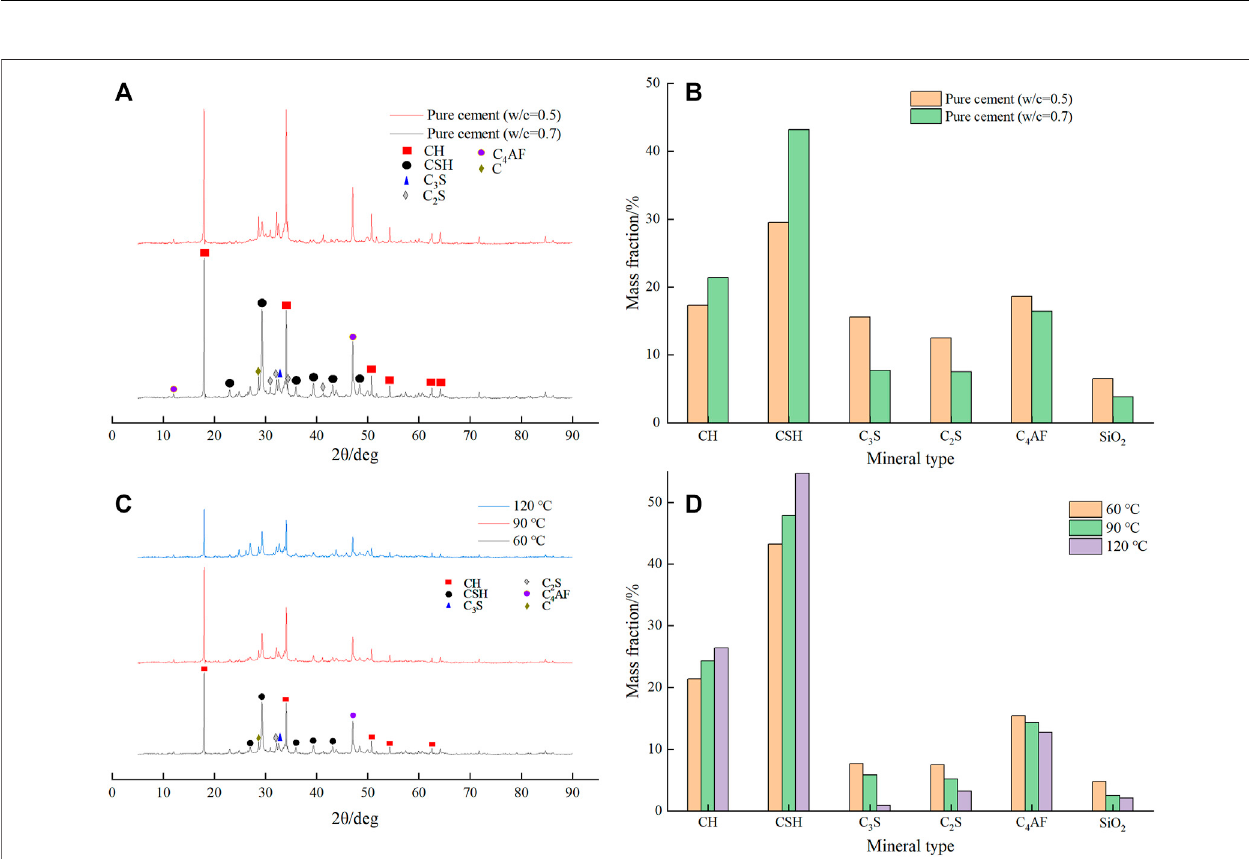
FIGURE 3 | XRD test results of pure cement with w/c ratio of 0.5 and 0.7. (A) XRD results of pure cement with w/c ratio of 0.5 and 0.7. The curing temperature is 60 ° C. (B) Mineral content statistics of Panel (A) results. (C) XRD results of pure cement (w/c = 0.7) under different curing temperatures. (D) Mineral content statistics of Panel (C)